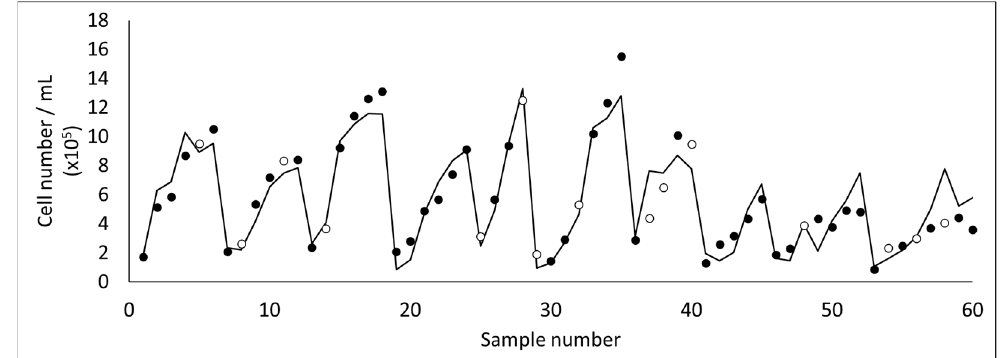
Figure 7. Experimental data (black circles for training and open circles for test) and model prediction (line) of microalgal cell concentration during ultrafiltration experiments and cell growth.